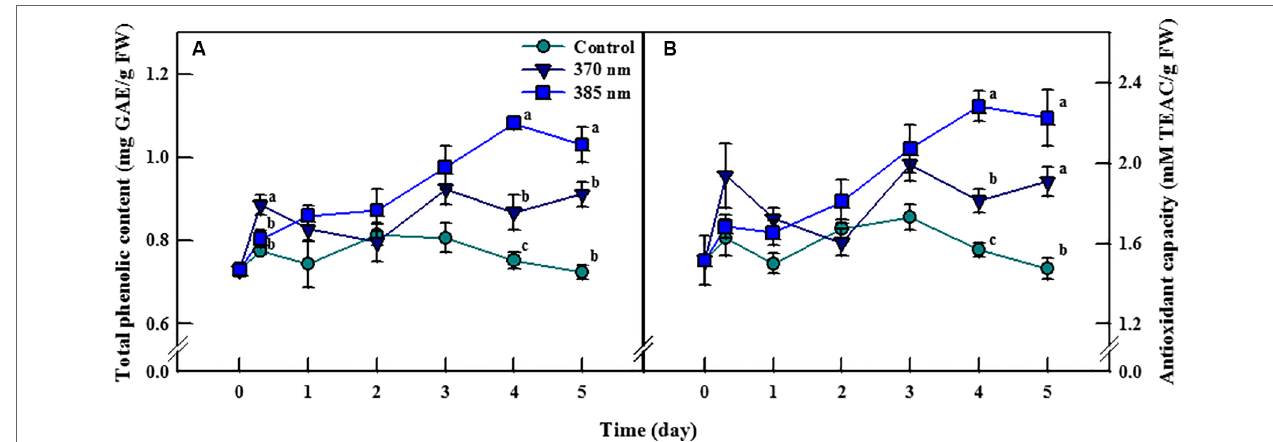
FIGURE 3 | Total phenolic content (A) and antioxidant capacity (B) of kale subjected to two types of UV-A LED lights for 5 days. The vertical bars indicate standard errors (n = 4). Different letters indicate significant differences, as assessed by ANOVA ( p <